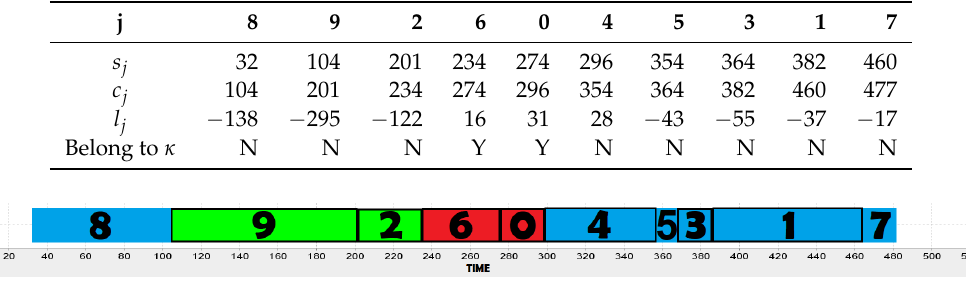
Table 6. Initial solution σ of the instance N_3_10.